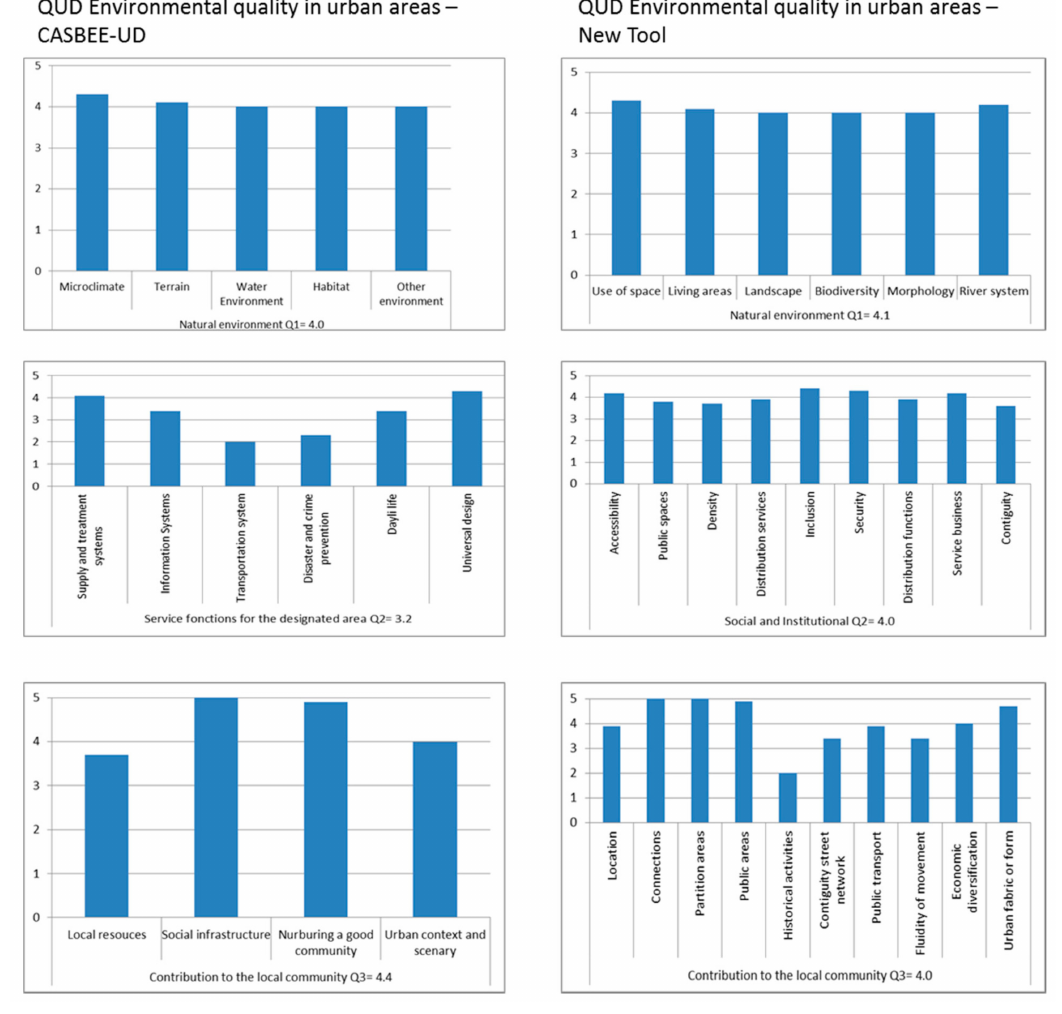
Figure 3. Comparison results of environmental quality (Q UD )